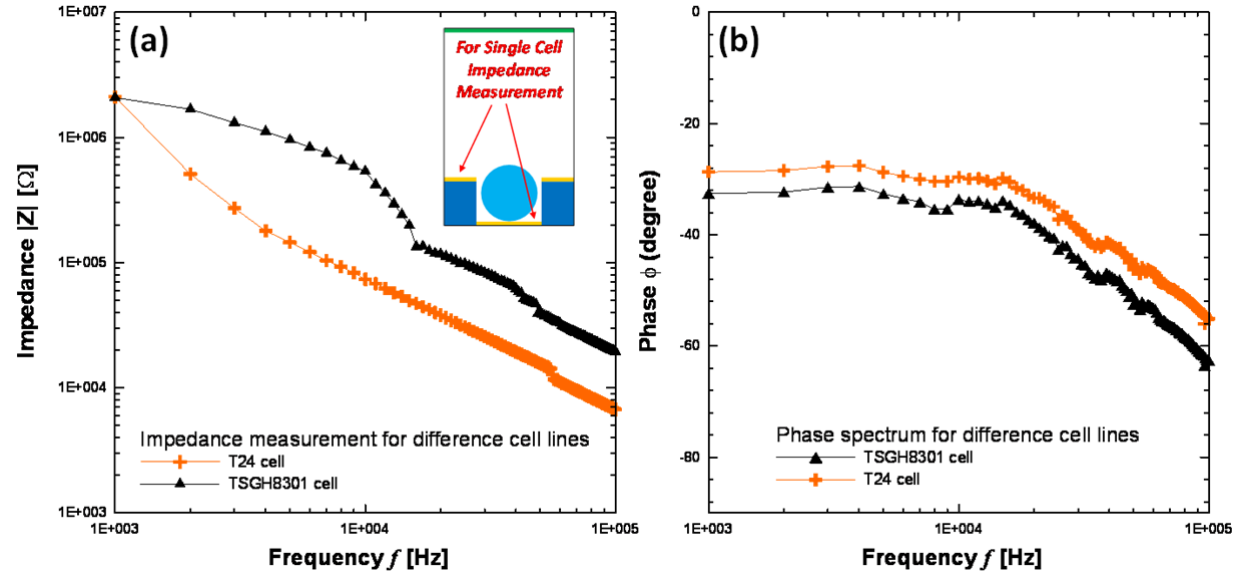
Figure 11. Impedance measurement results for difference bladder cancer cells (T24 & TSGH8301); the applied voltage was 1 V and the frequency range was swept from 1 K to 100